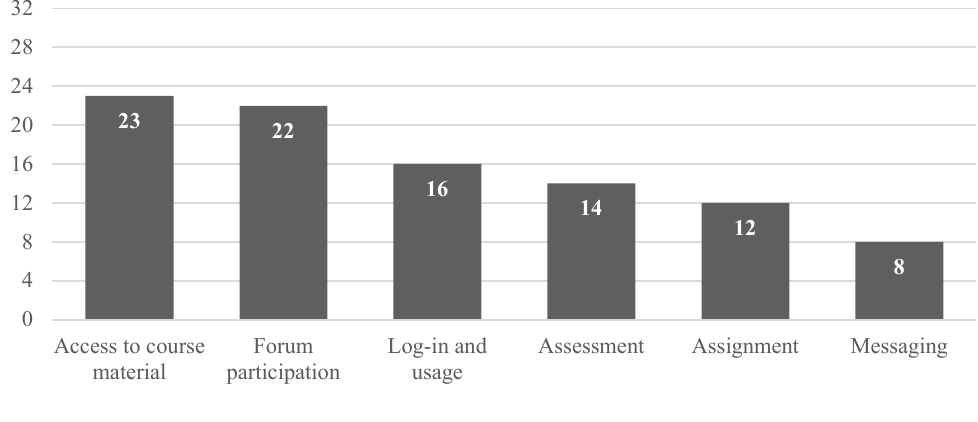
Frequency of Articles Stating Each Category of Student Engagement Indicators in LMSs